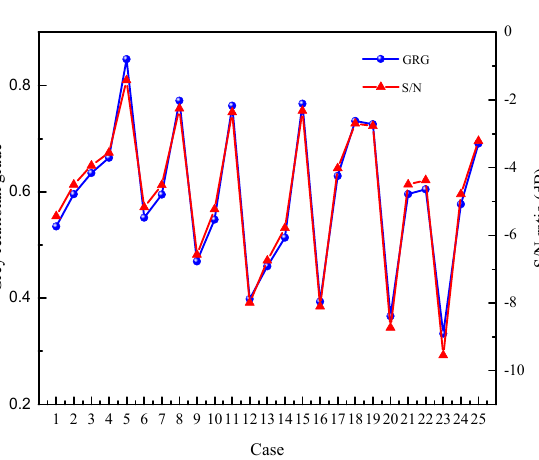
Figure 17. Grey relational grades presented in Table 12 and their S / N (signal to noise) ratio.